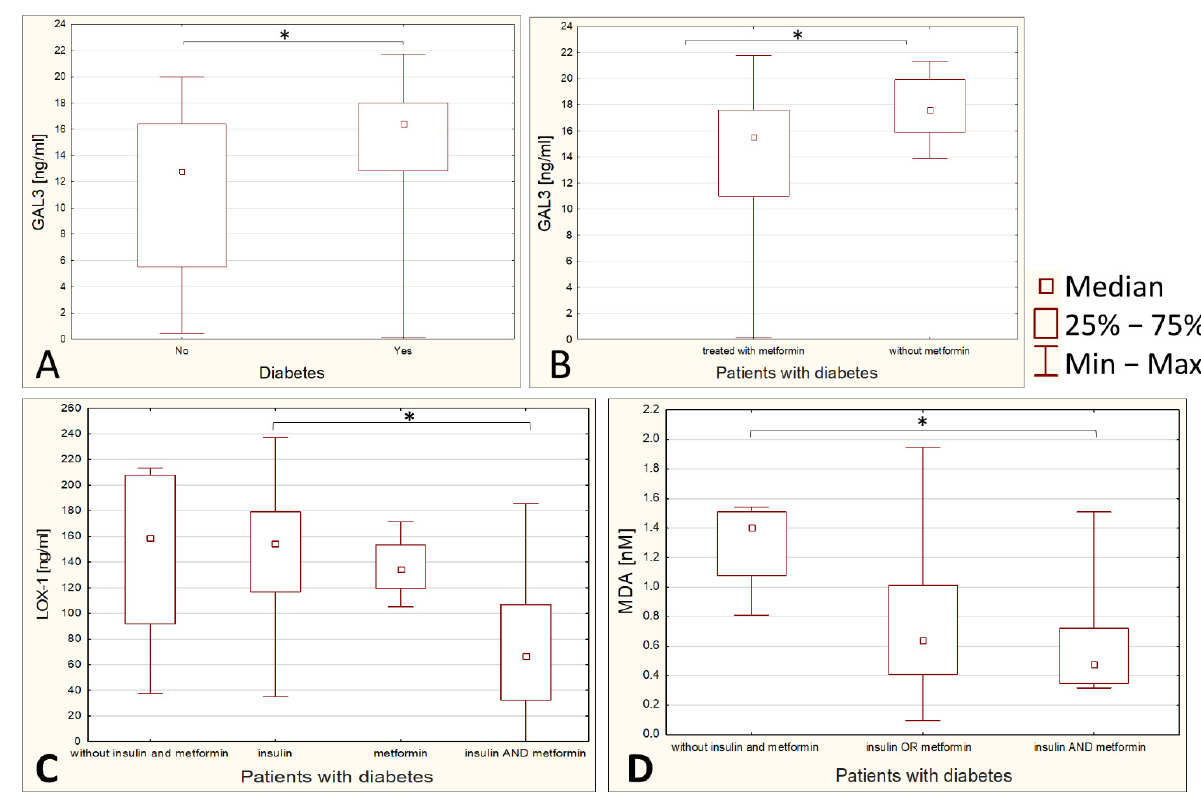
Figure 3. Group comparison between variables (box and whisker plots). Comparison of GAL3 levels in patients with and without diabetes (panel A ). Comparison of GAL3 levels in patients taking and not taking metformin (panel B ). Comparison of LOX-1 levels in diabetic patients not treated with insulin or metformin, those treated with insulin, those treated with metformin, and those treated with both medications simultaneously (panel C ). Comparison of MDA levels between diabetic patients not treated with insulin or metformin, those treated with insulin or metformin, and those treated with both medications simultaneously (panel D ). An asterisk (*) indicates between which groups the difference is statistically significant.